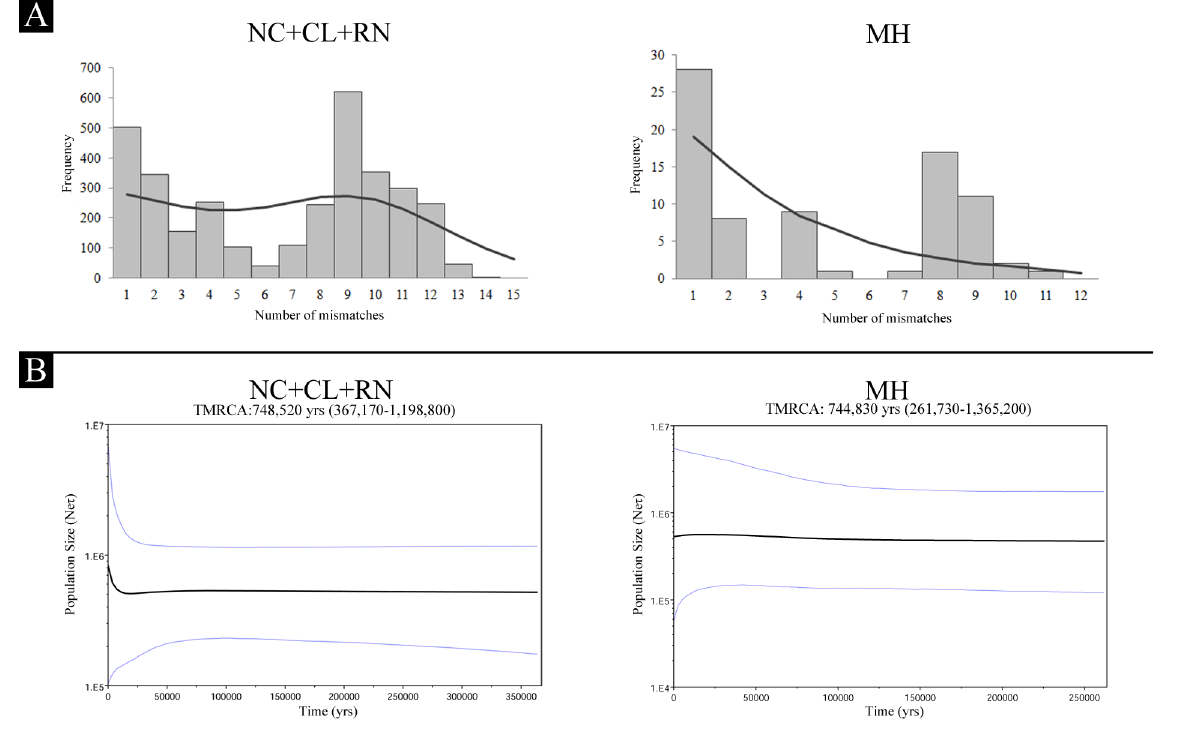
Fig 3. Demographic history based on the mtDNA control region sequences from populations NC+CL+NC and MH. A) Mismatch distributions. Observed and expected distributions are shown with bars and lines, respectively. B) Bayesian skyline plots. The black line is the median estimated and the blue lines show the 95% highest posterior density (HPD) intervals. NC: Necochea; CL: Claromecó; RN: Río Negro; MH: Monte